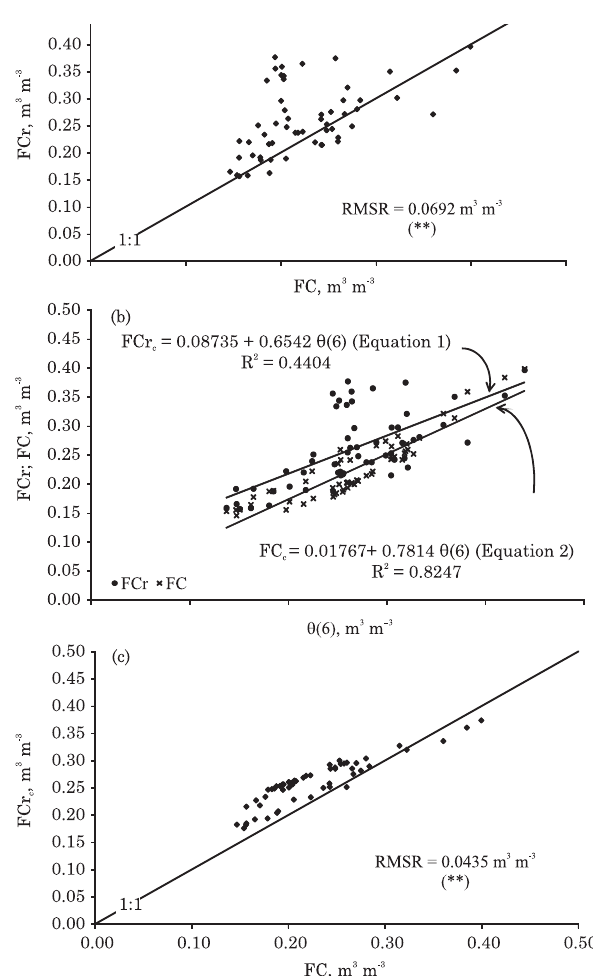
Figure 2. Relationships involving standard field capacity (FC), ring field capacity (FCr), and θθθθθ (6) data. In (a), FC is compared to FCr. In (b), the regression equations for FCr vs θθθθθ (6) (Equation 1) and FC vs θθθθθ (6) (Equation 2) are represented. In (c), the values calculated by equation 1 are evaluated in comparison to the FC data. **: means that the variable at the vertical axis is statistically distinguishable from FC (at p<0.01), according to the Wilcoxon test